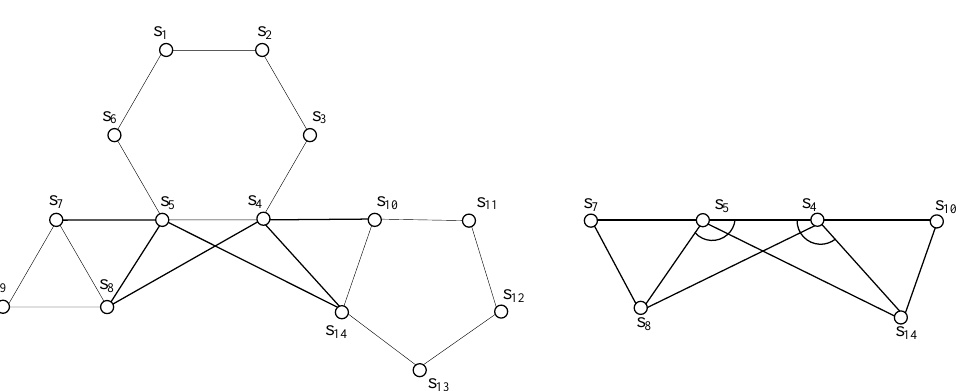
Figure 4. Adding a circle to a MST.